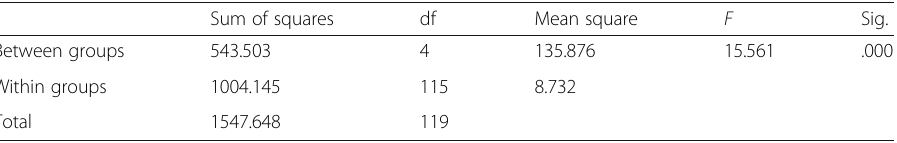
Table 7 ANOVA for the TOEFL iBT test Sum of squares df Mean square